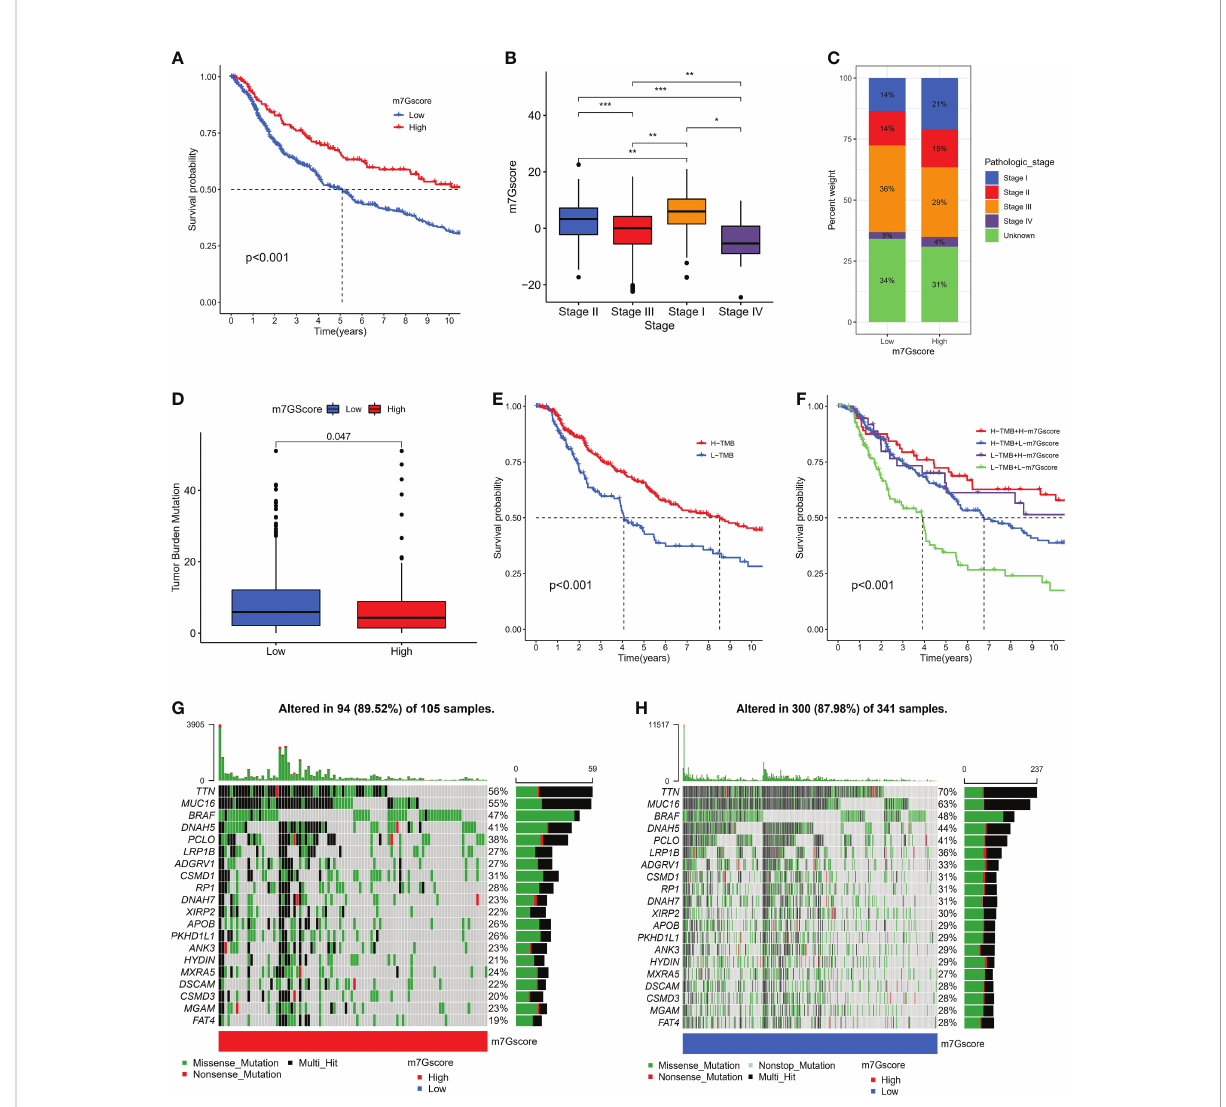
FIGURE 5 The connection between m7G score and clinical characteristics. (A) K-M survival analysis of OS in high and low m7G score groups in meta- SKCM cohort (p < 0.001). (B, C) The association between m7G score and clinicopathologic stage. (*p < 0.05 **p < 0.01 ***p < 0.001). (D) The difference of TMB in high versus low m7G score(p=0.047). (E) K-M survival analysis of OS in high and low TMB subgroups in the meta-SKCM cohort (p <0.001). (F) M7G score combined with TMB better predicted the prognosis of SKCM patients. (G, H) Mutational landscape of signi fi cantly mutated genes (SMGs) strati fi ed by high (left panel) versus low m7G score (right panel) subgroups. Mutation types were used in different colors as